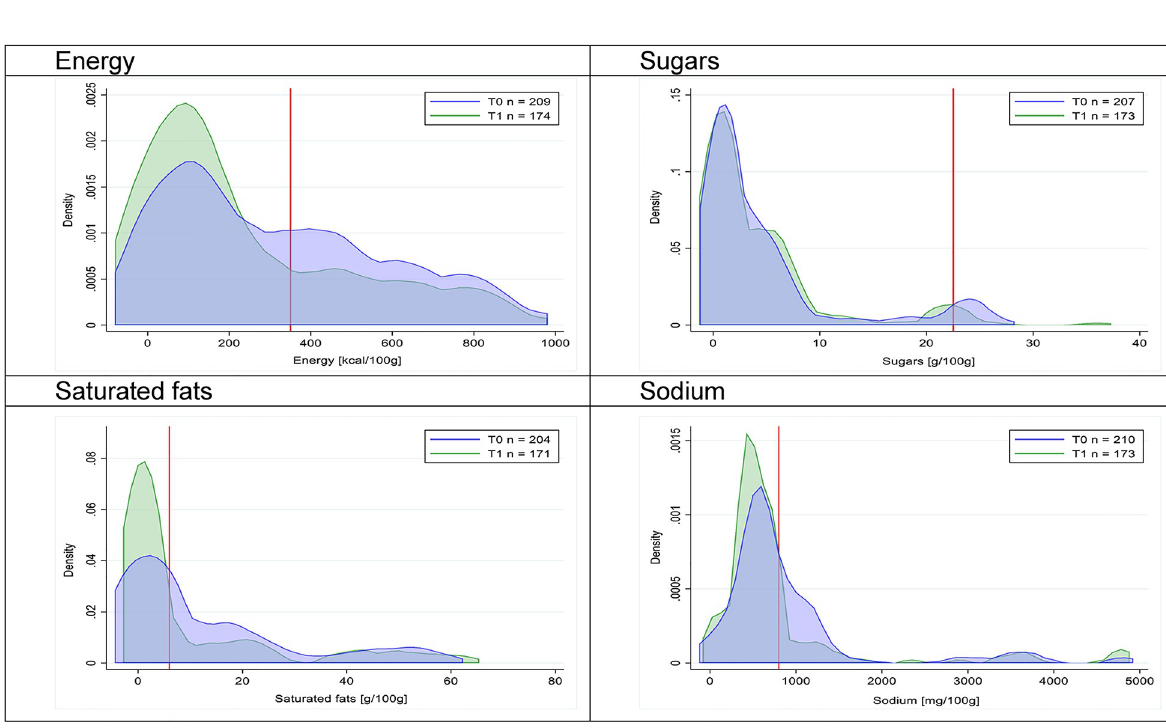
Fig 12. Density curves for the amount of energy and nutrients of concern in savory spreads, cross-sectional samples. The blue line represents the distribution in T0 (preimplementation), the green line represents the distribution in T1 (postimplementation), and the red line represents the cutoff for the amount of energy or nutrients of